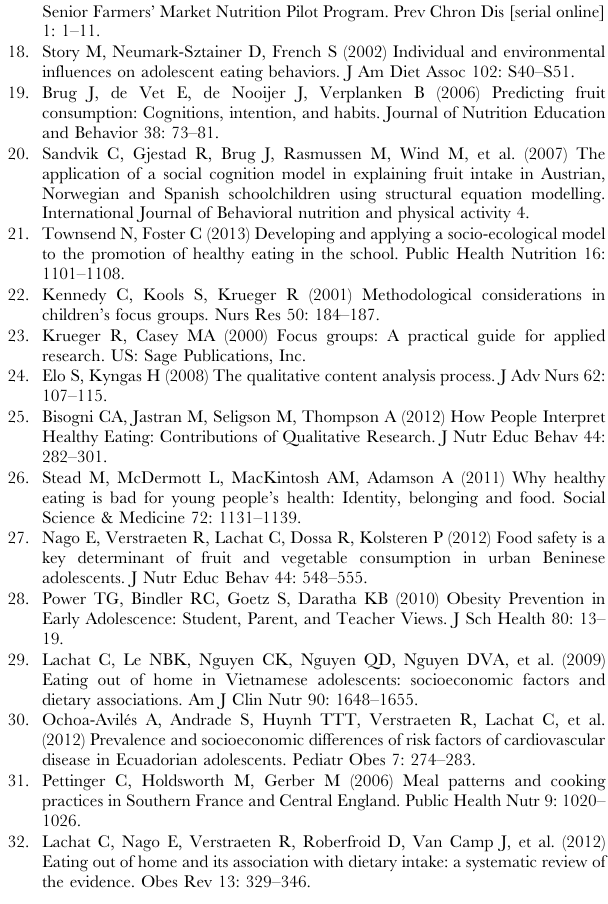
Table S1 Quotes on individual factors influencing eating behavior in adolescents, parents and school staff.